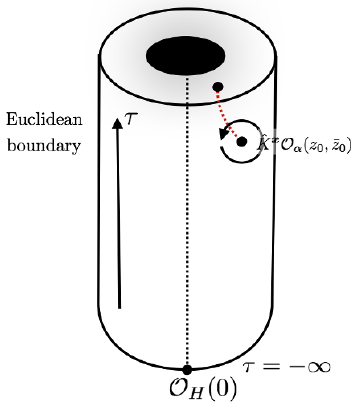
Figure 8 . We can use the same way to construct the bulk local states from the heavy primary states as far as these background states look \thermal". Thermality of the correlators are brought by the vacuum conformal block approximation of the